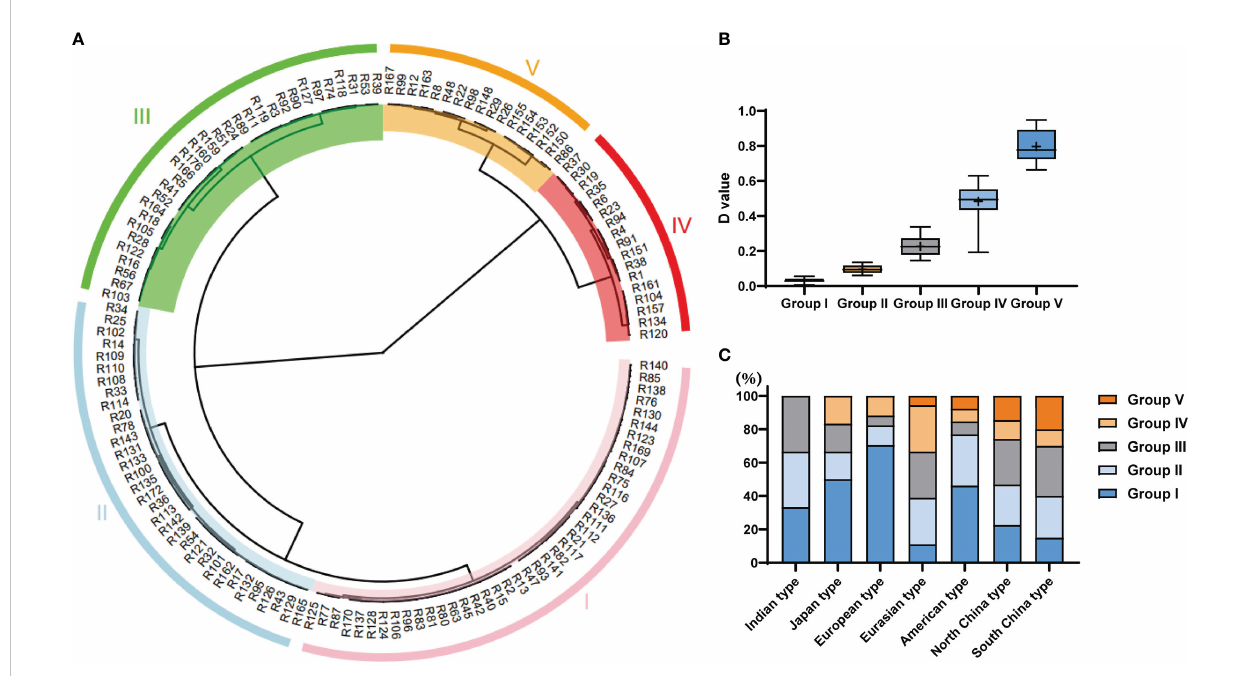
FIGURE 3 Analysis of the cucumber accessions based on their tolerance to germination at low temperatures. (A) Clustering of accessions of the core germplasm collection using the comprehensive D-value to indicate germination at low temperature. The I, II, III, IV and V indicate group I, group II, group III, group IV, and group V, respectively. (B) The range of D-values from Group I to Group V. (C) The proportion of Group I to Group V of D- values found within the different ecotypes.